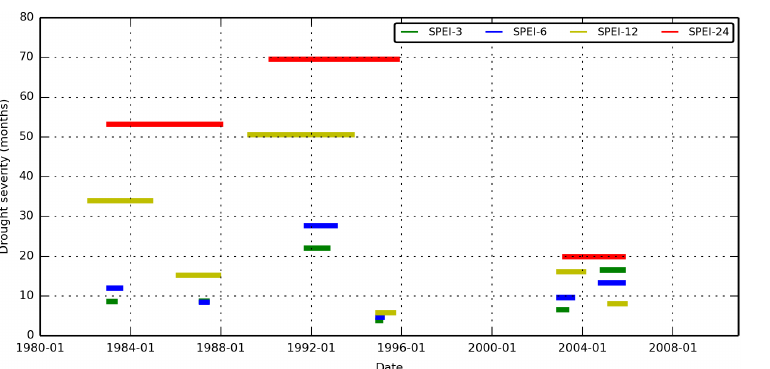
Figure 10. Drought severity and duration in subbasin 24 for the six most severe droughts in the period 1980–2010 for the indicator SPEI with different aggregation